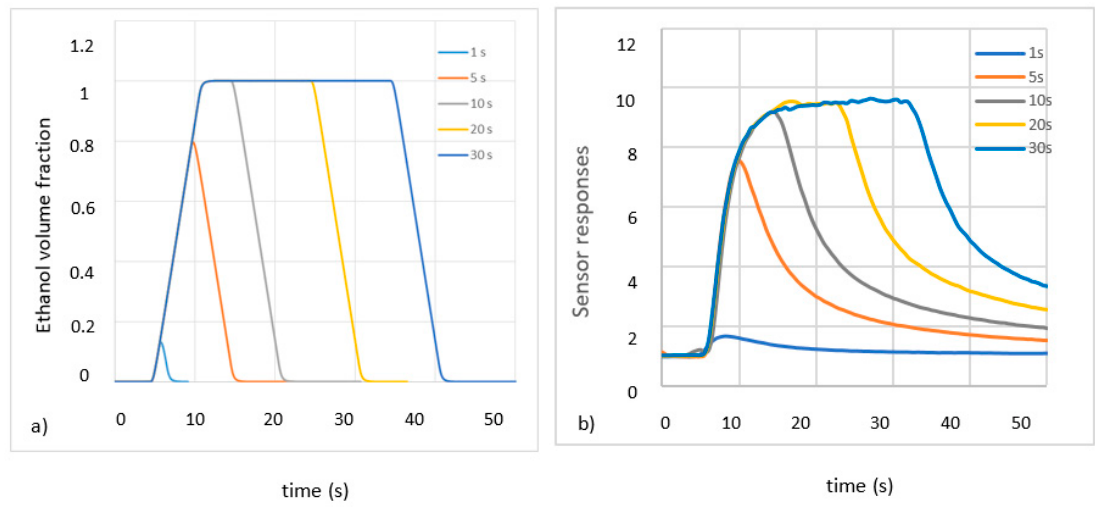
Figure 4. ( a ) Simulation results of ethanol concentration (25 ppm) diffusion inside the boat chamber and ( b ) experimental sensor responses toward the same ethanol concentration, using boat chamber and different exposure